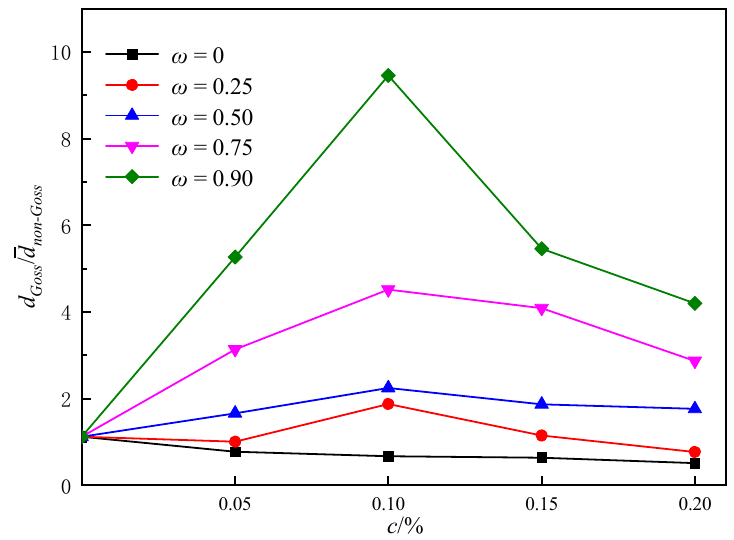
Figure 13. The size ratio of Goss grains to non-Goss grains under various c and ω s. Thus, it can be known that abnormal growth can be induced by the addition of par- ticles, and the level depends on the combined effect of the particle content and the dis- solvability of Goss GBs. When the dissolvability is strong and the particle content is high, non-Goss grains are pinned by particles, and Goss grains exhibit fast evolution. This will result in a rapid increase in the number of Goss grain sides, which can further accelerate